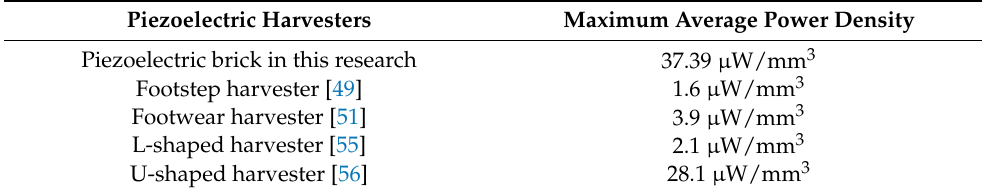
Table 5. The maximum average power density of the piezoelectric